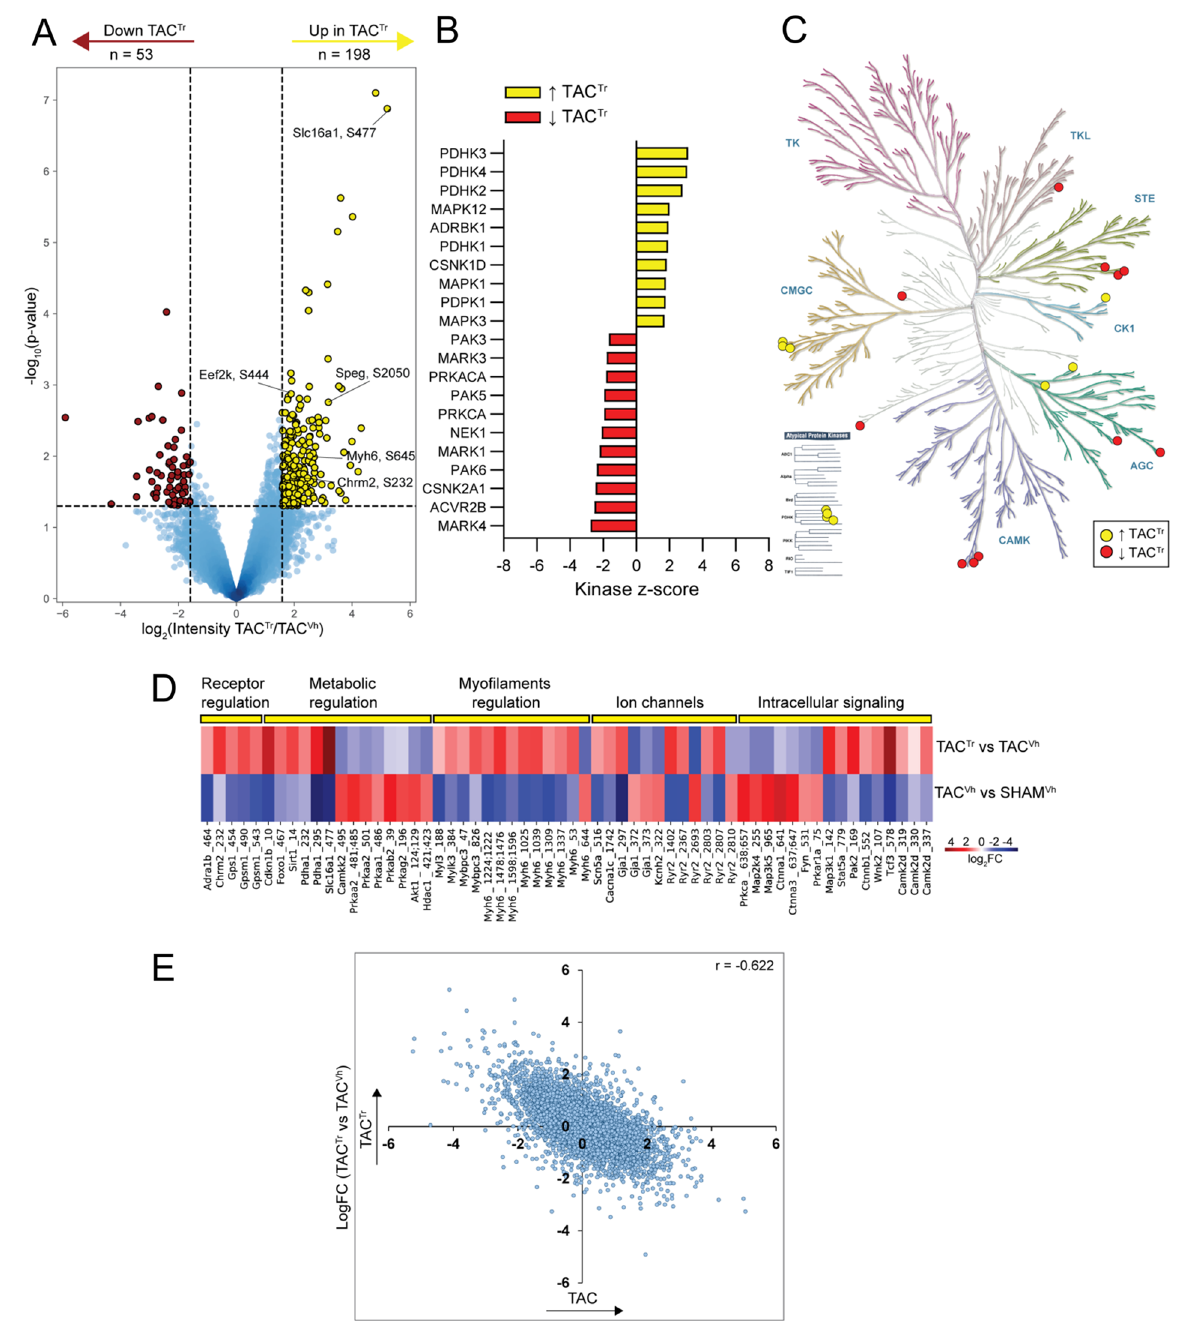
Figure 4. Phosphoproteome regulation in response to treatment in TAC animals. ( A ) Volcano plot analysis evaluating phosphorylation response in heart failure mice in response to drug treatment (TAC Tr versus TAC Vh ). The plot shows phosphorylated peptides that are downregulated (red) or upregulated (yellow) in animals with heart failure in response to drug treatment. ( B ) Kinase-Substrate Enrichment Analysis results that show kinases with either up- (yellow) or down regulated (red) activity in the TAC Tr hearts compared to TAC Vh hearts. ( C ) Phylogenetic tree of the kinome (KinMap 71 ) visualizing kinases with upregulated (yellow) or downregulated (red) activities in heart failure animals upon drug treatment. ( D ) Heat map visualizing the fold-change in site-specific phosphorylation for select proteins with essential cardiac functions. The lower panel shows the fold-change between TAC Vh and SHAM Vh . The upper panel shows the fold-change between TAC Tr and TAC Vh . The phosphorylation change in response to TAC is reversed by the treatment. ( E ) Scatter plot of fold-changes for all measured phosphorylated peptides with the fold-change for TAC Tr /TAC Vh shown as function of fold-change in TAC Vh /SHAM Vh . There is a negative correlation for the phosphorylation fold- changes. The Pearson correlation coefficient (r) is